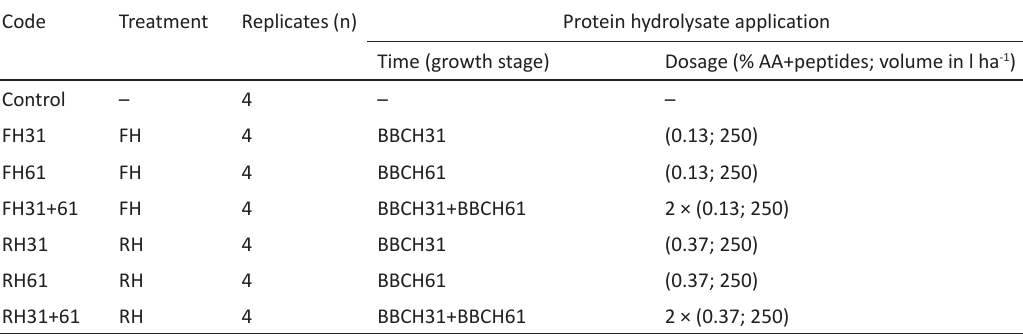
Table 3. List of experimental treatments used in the field experiment Code Treatment Replicates (n) Protein hydrolysate application Time (growth stage) Dosage (% AA+peptides; volume in l ha -1